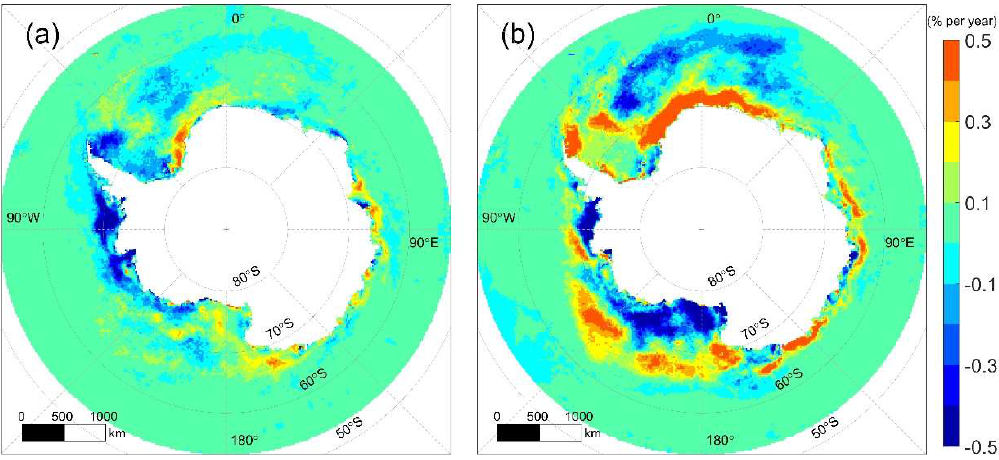
Figure 12. Spatial distribution of the pixel-based trend of the SAL (% per year) during summer: trend from 1982 to 2001 (a); trend from 2001 to 2015 (b).